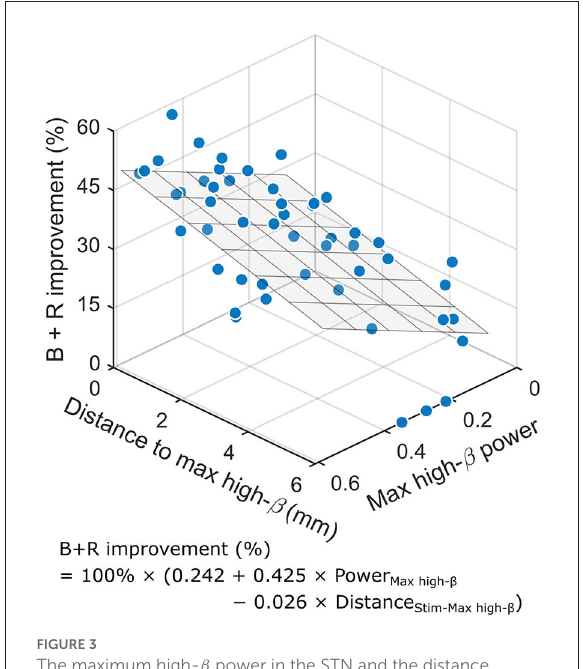
FIGURE3 The maximum high- β power in the STN and the distance between the contact with maximum high- β oscillation and the active contact are significant predictors for the improvement in bradykinesia and rigidity with DBS. The 3D graph demonstrates the results of the multiple linear regression model. The higher the high- β power and the shorter the distance between the active contact and the contact with the maximum high- β oscillations, the greater the improvement in B + R due to DBS on contralateral limbs. The fitting formula is inset. The overall regression is significant [ R 2 = 0.374, F (2,47) = 14.061, p = 1.6 × 10 − 5 ]. The regression plane is displayed. B, bradykinesia; R,